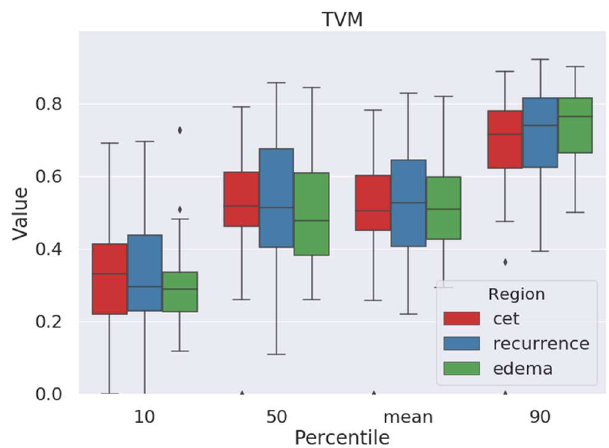
Figure 2. Tissue-volume fractions of contrast-enhancing tumor (red), pure edema (green), and area of peritumoral edema with later recurrence (blue). No significant di ff erence between edema with later tumor recurrence and recurrence-free edema. Diamonds denote outliers. Table 1. Comparison of di ff erent percentiles and mean of tissue volume, mean di ff usivity, and fractional anisotropy between pure peritumoral edema and edema with later recurrence without (original values, left) and after free water correction (free-water-corrected, right). p -Value Edema vs. Recurrence, Free-Water-Corrected (FWC) FA